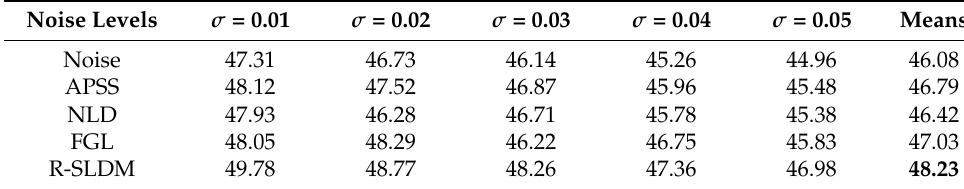
Figure 7. Denoising results of FGL under different noise intensities: ( a ) FGL (𝜎 = 0.2) ; ( b ) FGL (𝜎 = 0.4) . Table 1. SNR (DB) of five different denoising algorithms for Daratech models.